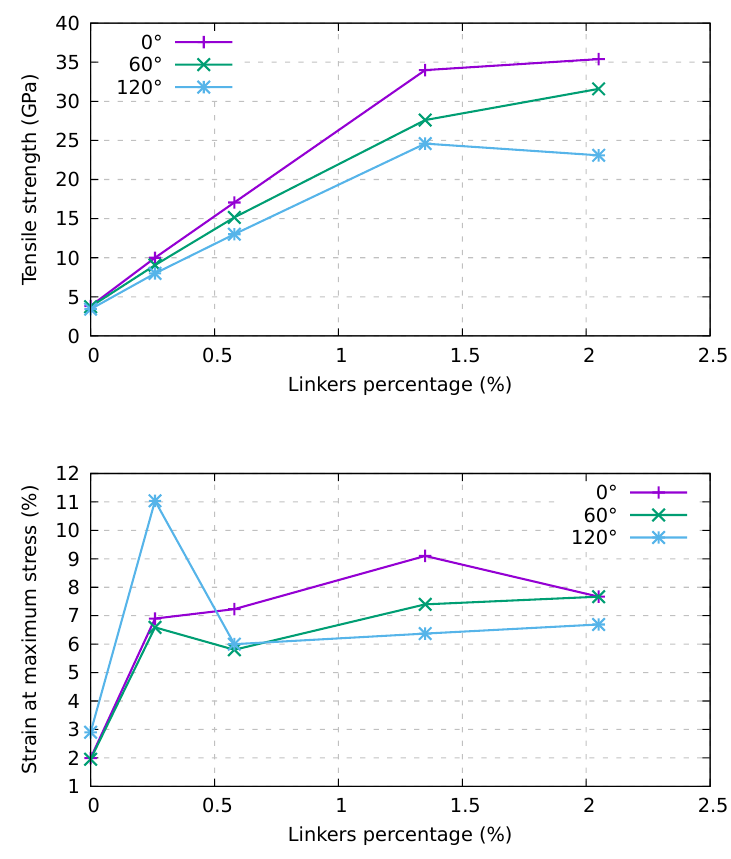
Figure 7. Dependence on twisting and percentage of linkers of the tensile strength ( top ) and strain at maximum stress ( bottom ) for an infinite bundle composed of ( 6,6 ) CNTs with a periodic supercell of 20 nm in length. AIREBO-mod potential and a strain velocity of 1.0 Å/ps were used. Again, Young’s modulus (see Figure 6) is still independent of those parameters. This behavior is expected for bundles composed of infinite length CNTs; for finite length CNTs, this behavior is related to the high velocity of our test coupled with the remapping of the atoms. Indeed, the atoms are remapped in the cell during the simulations so that, in the first part of the stress–strain curve, Young’s modulus depends on the carbon atoms within the tubes rather than the linkers. After a short period of time, the stress within the bundles evolves differently for different structures. This interpretation is supported by the fact that, for the samples with the higher percentage of linkers, the slope of the stress–strain curve is almost constant up to 2% strain. Moreover, for infinite-length bundles, Young’s modulus is the same in all cases, and the curves are almost identical up to 5% strain; at odds, finite-length nanotubes start diverging after 0.25% strain. In the latter case, we can compute Young’s modulus using values between 0.25% and 2% strain, where they are rather linear. Young’s modulus values for the various samples are reported in Figure 8. We note that Young’s modulus increases monotonically with an increase in linker percentage and decreases with the twisting angle. It is also worth noting the difference in tensile strength reported in Figure 7 (top panel), where the tensile strength increases linearly with the linker percentage (up to about 1.4%). Young’s modulus presents a large increment at small strain and then smoothly saturates beyond 1.4%. These findings suggest that an increment of Young’s modulus can be obtained at a lower linker percentage, while, conversely, to maximize such increment in the tensile strength, a higher linker percentage should be